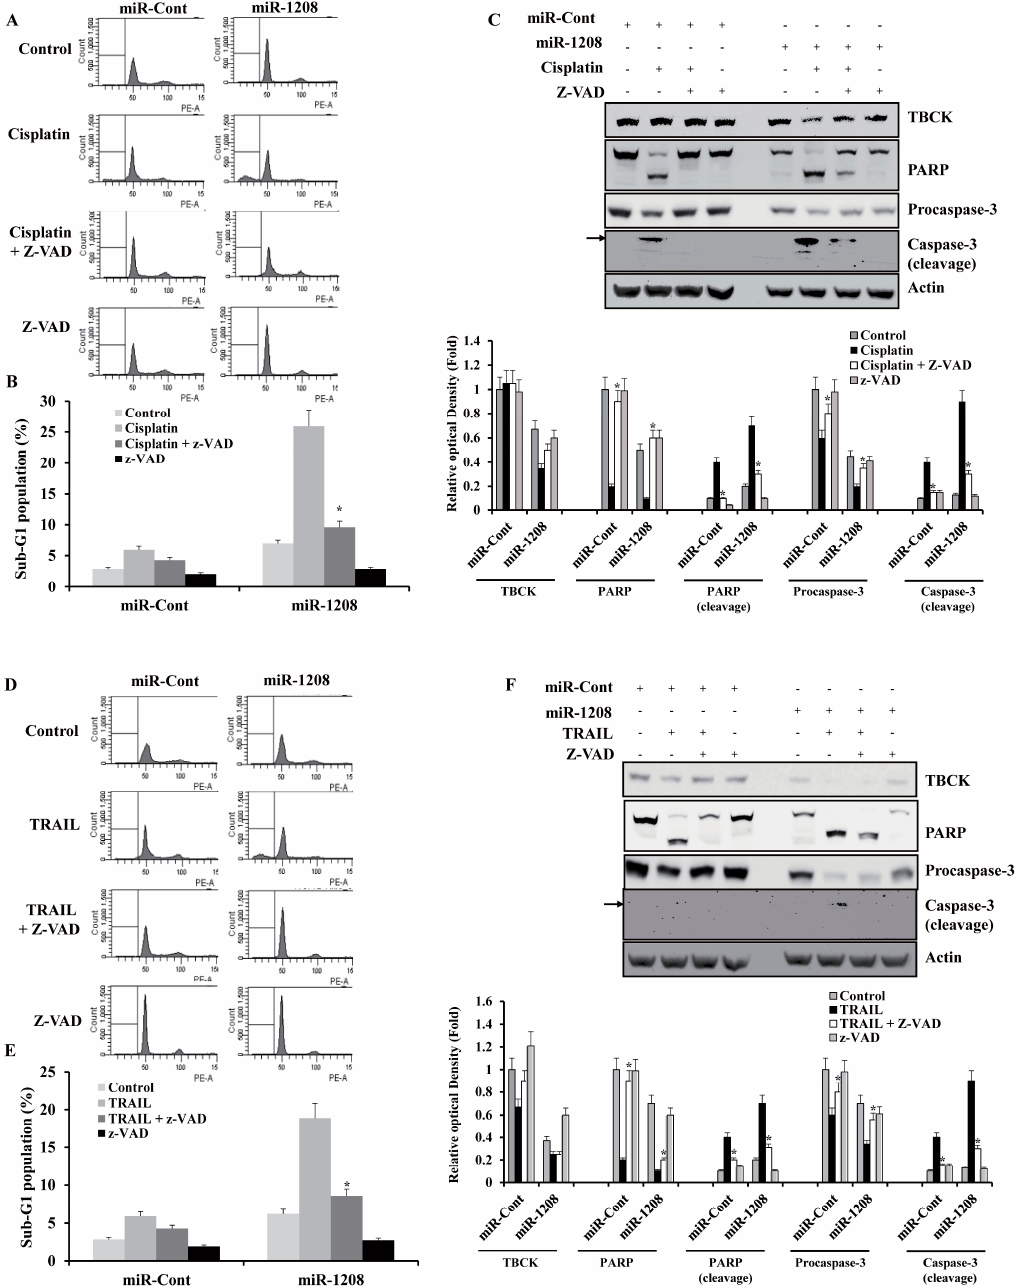
Figure 6. Ectopic expression of miR-1208 promotes cisplatin- or TRAIL-induced apoptosis through activation of caspase cascades. ( A ) Caki-1/miR-1208 cells were incubated with 50 μ M z-VAD-fmk or solvent for 1 h before treatment with cisplatin for 24 h. FACS analysis was performed to measure a sub-G1 fraction. Histograms of flow cytometry are shown. (B) Percentages of sub G1 populations are shown. Data are reported as the mean ± SD ( n = 3). . * indicates P < 0.05 versus cisplatin-treated cells. ( C ) Equal amounts of cell lysates (50 μ g) were loaded to electrophoresis and were immunoblotted for PARP and caspase-3 antibodies. Actin was used for normalization in all immunoblots. Using ImageJ software, the intensity of each protein in miRNA and cisplatin-treated cells were normalized to actin and expressed as a ratio of the densitometric value ( bottom panel ). * indicates P < 0.05 versus cisplatin-treated si-Cont- or miR-1208-transfected cells. ( D ) Caki-1/miR-1208 cells were incubated with 50 μ M z-VAD-fmk or solvent for 1 h before treatment with TRAIL for 24 h. FACS analysis was performed to measure a sub-G1 fraction. Histograms of flow cytometry are shown. (E) Percentages of sub G1 populations are shown. Data are reported as the mean ± SD ( n = 3). . * indicates P < 0.05 versus TRAIL-treated cells. ( F ) Equal amounts of cell